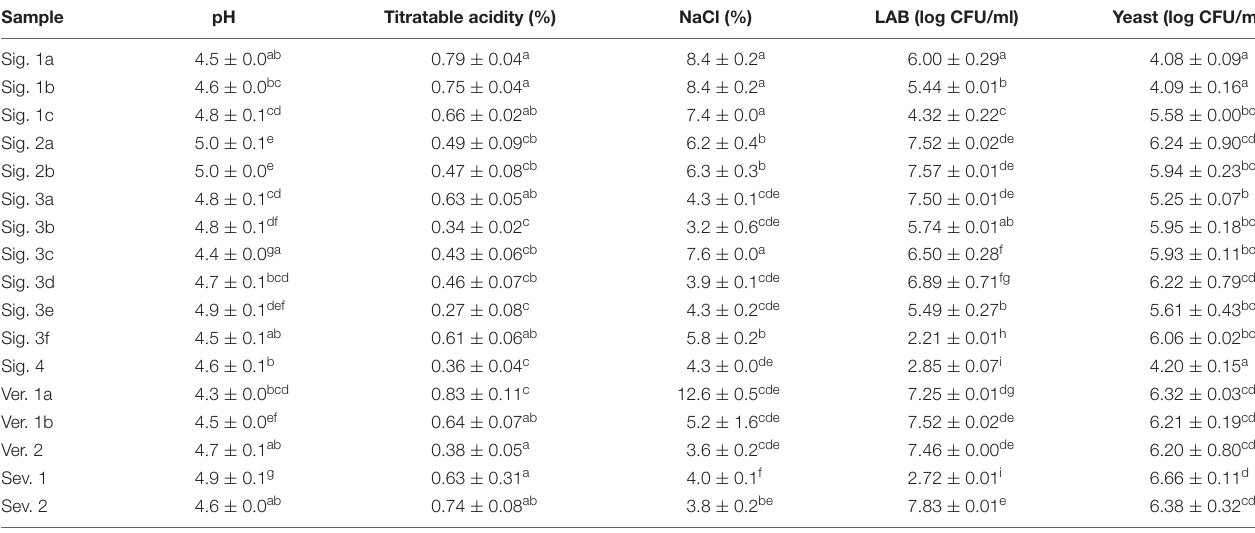
TABLE 3 | Chemical characteristics and viable microbial population of industrial Spanish-style green olive brines after fermentation.